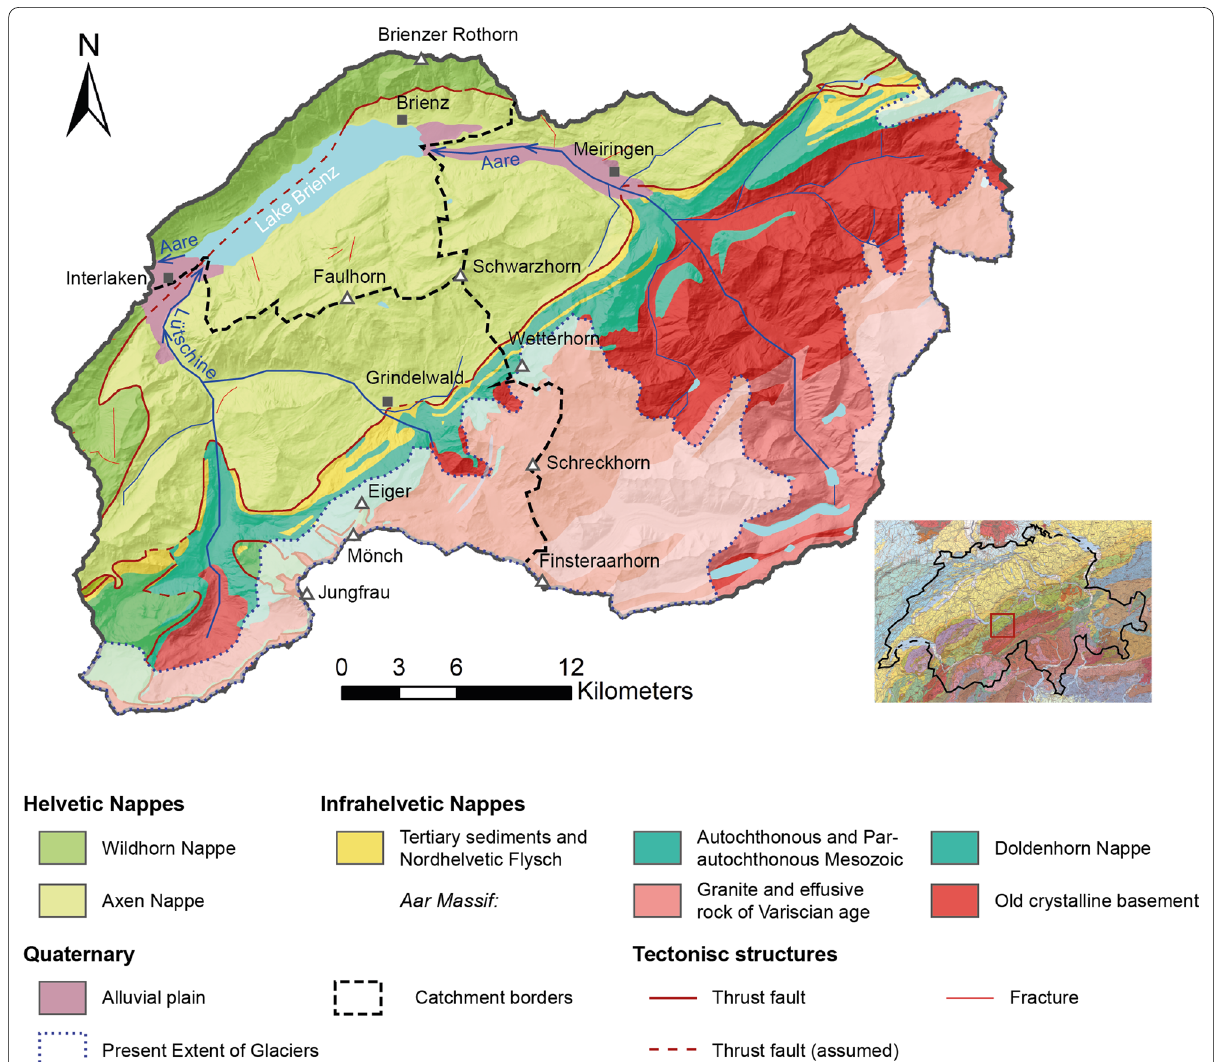
Fig. 1 Tectonic map (superimposed on shaded relief using swisstopo swissALTI3D digital elevation model) of Lake Brienz’ catchment area. Sub-catchment borders of Lütschine and Aare are represented by black dashed lines. Inset shows tectonic map of Switzerland (GK500-Tekto,